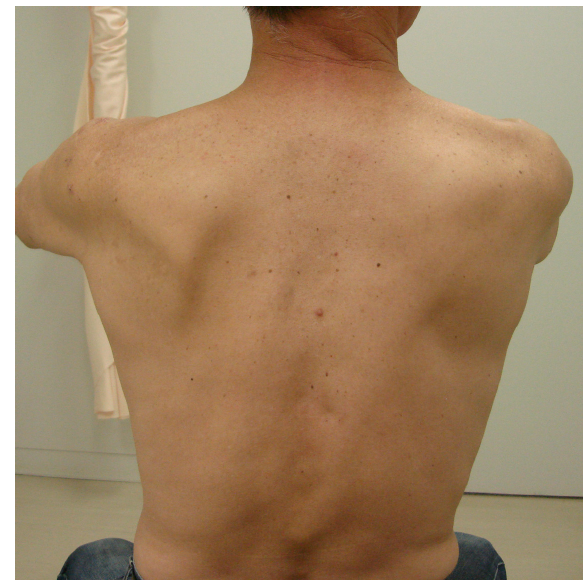
Figure 1. Atrophy of the left infraspinatus muscle caused by suprascapular neuropathy with a spinoglenoid